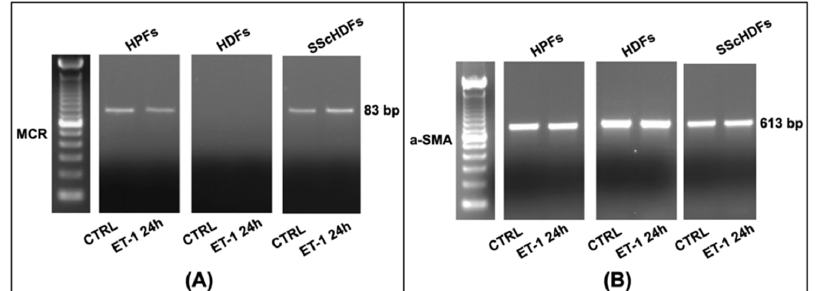
Figure 3. ET ‐ 1 effects on MCR ( A ) and α‐ SMA ( B ) in HPFs, HDFs, and SScHDFs. MCR mRNA was not detectable in HDFs before and after ET ‐ 1 stimulation for 24 h, whereas α‐ SMA mRNA was pre ‐ sent before and after ET ‐ 1 stimulation for 24 h in HPFs, HDFs, and SScHDFs. (HPFs: human pulmo ‐ nary fibroblasts; HDFs: human dermal fibroblasts; SScHDFs: scleroderma dermal fibroblasts; MCR: mineralocorticoid receptor; α‐ SMA: α‐ smooth muscle actin).